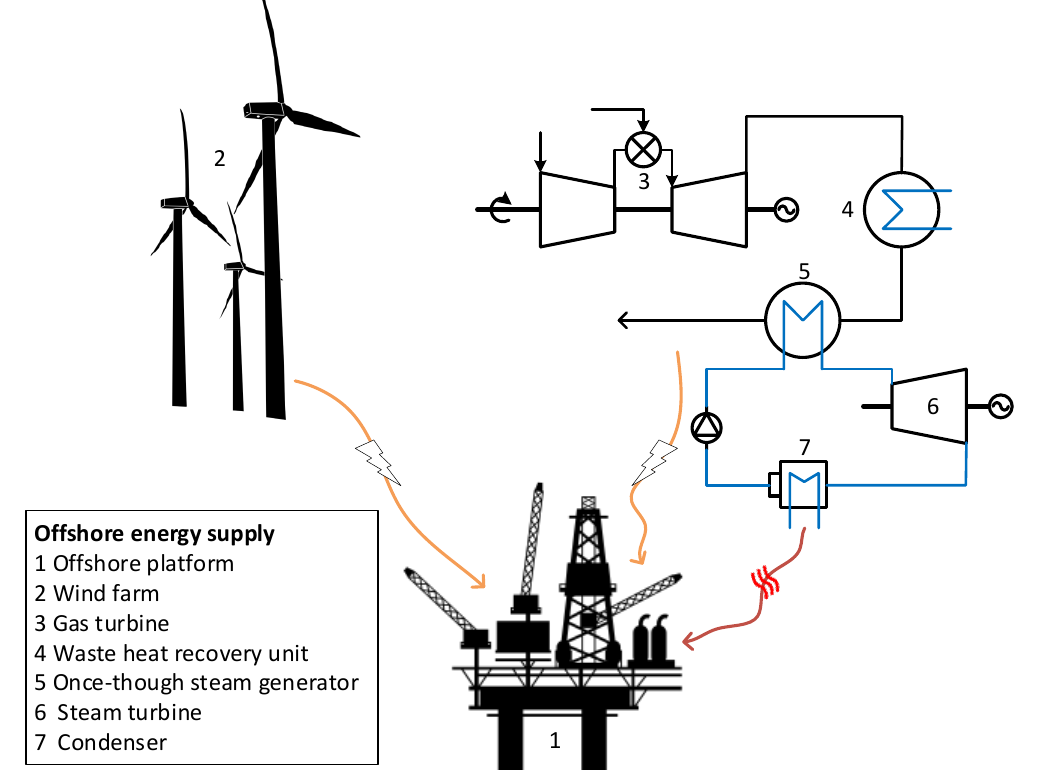
Figure 1. Layout of the offshore energy system integrating a wind farm and a combined cycle to supply energy to the processing block of a platform.